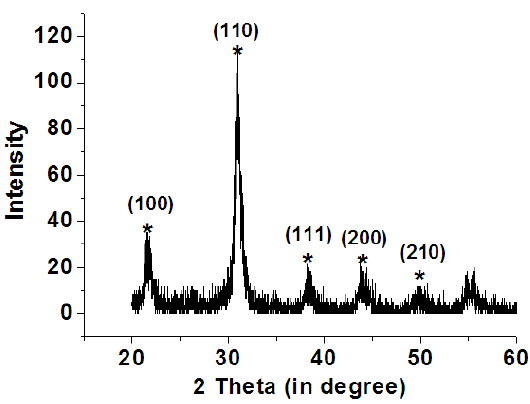
Figure 5. A PZT thin film crystal orientation on flexible stainless steel substrate.